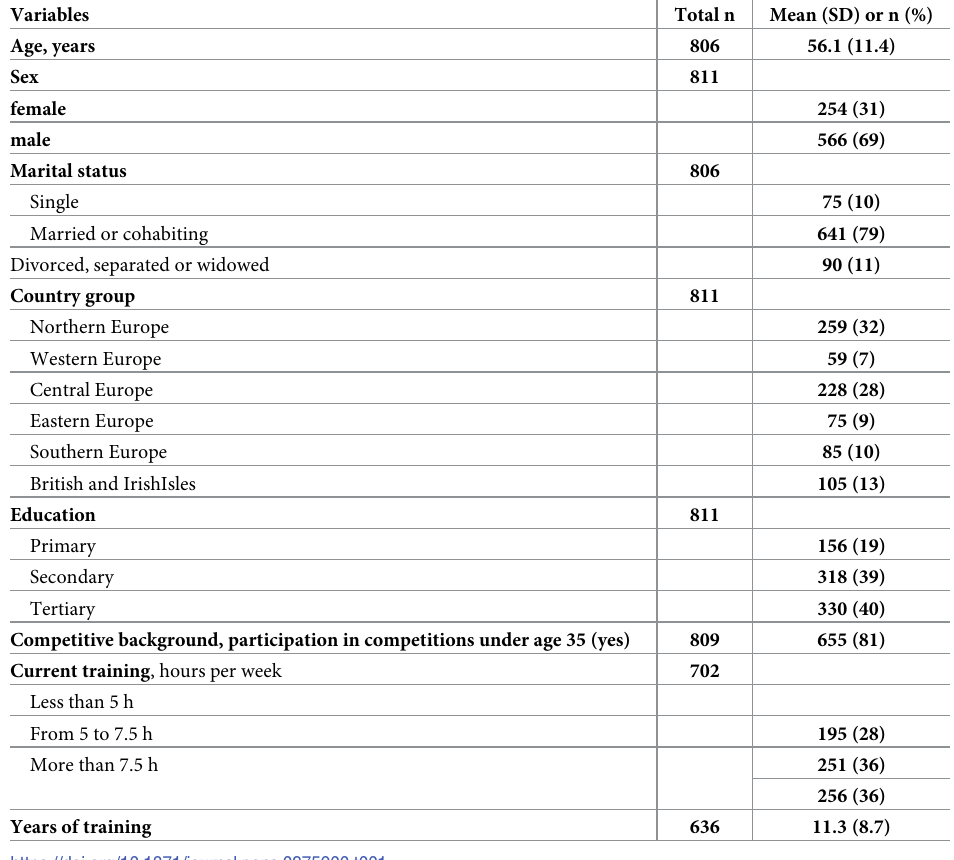
Table 1. Descriptive information of the